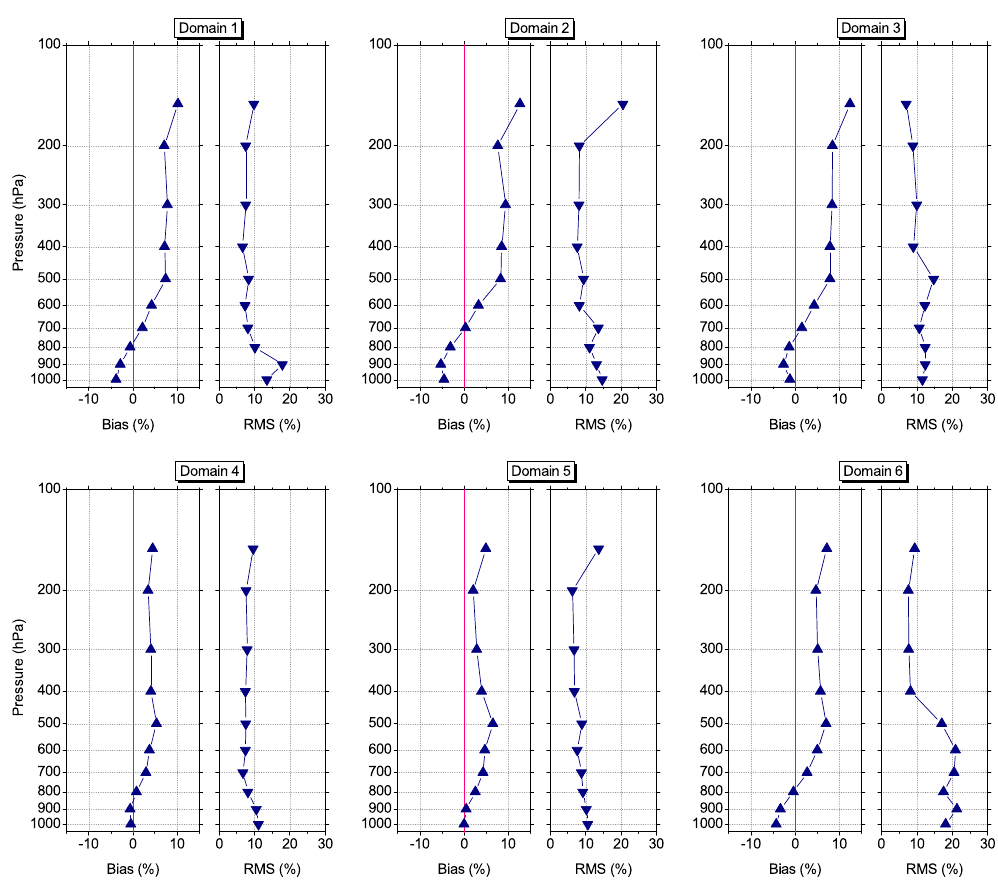
Figure 15. Same as Fig. 14 but for the mean bias and the corresponding RMS between both analyses (TOTCOL_ANALYSES and PRO- Fig. 15. Same as Fig. 14 but for the mean bias and the corresponding RMS (Root Mean Square) between both analyses (TOTCOL ANALYSES and PROFILE ANALYSES).